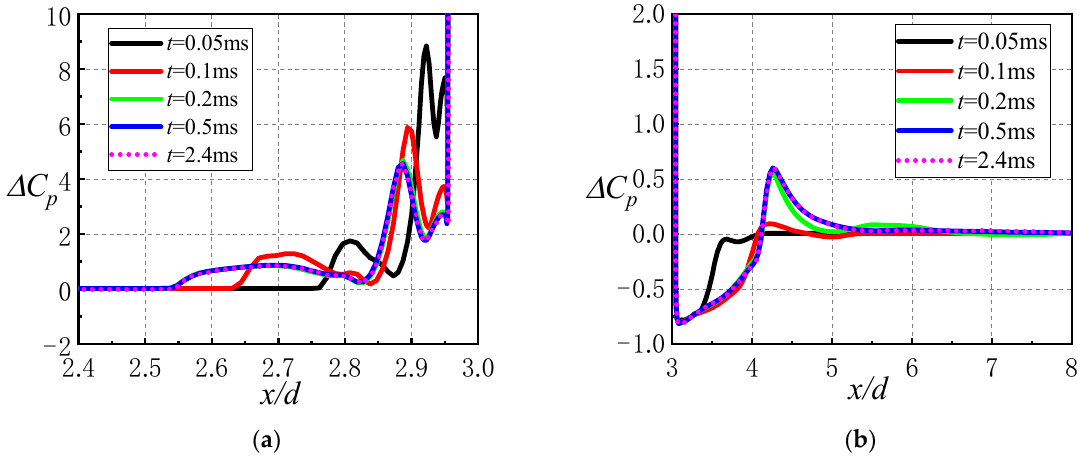
Figure 10. Variation s of jet interference force deflection angle, jet thrust angle and jet control force angle with time since lateral jet startup: ( a ) Deflection angle of the jet interference force; ( b ) (cid:2016) (cid:3021) and (cid:2016) (cid:3004)